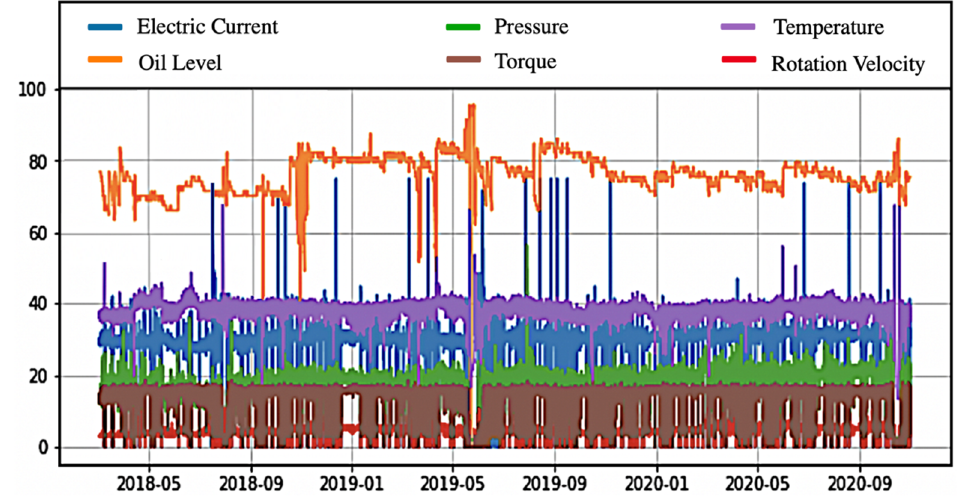
Figure 1. Plot of sensor data collected from 2018 to 2020 with a sampling period of 1 min . Raw data as provided by the company.